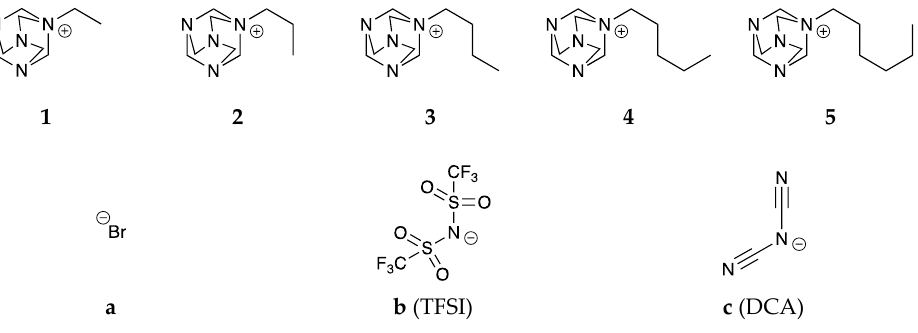
Figure 1. Chemical structures of the obtained compounds.